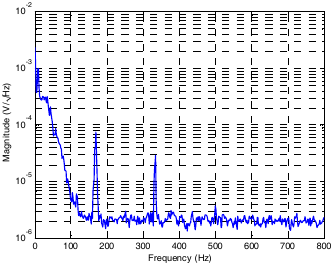
Figure 10. Spectral density of output signal.